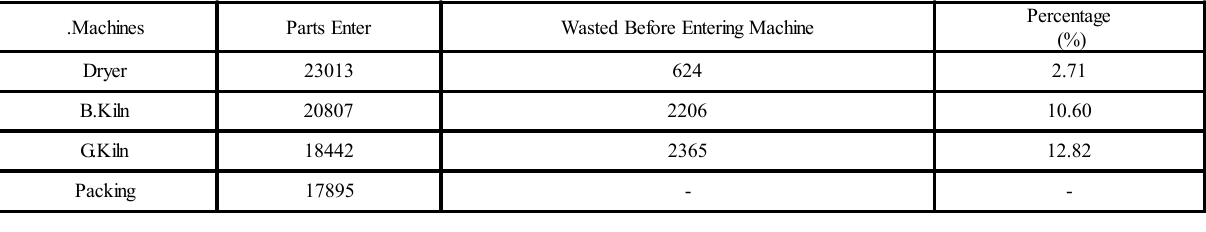
(c) TOP VIEW OF MODEL FROM START OF LINE TO PACKAGING FIG. 3. SIMULATION MODEL OF THE TILES PRODUCTION AREA IN TABLE 4. WASTES PRODUCED AT DIFFERENT POINTS